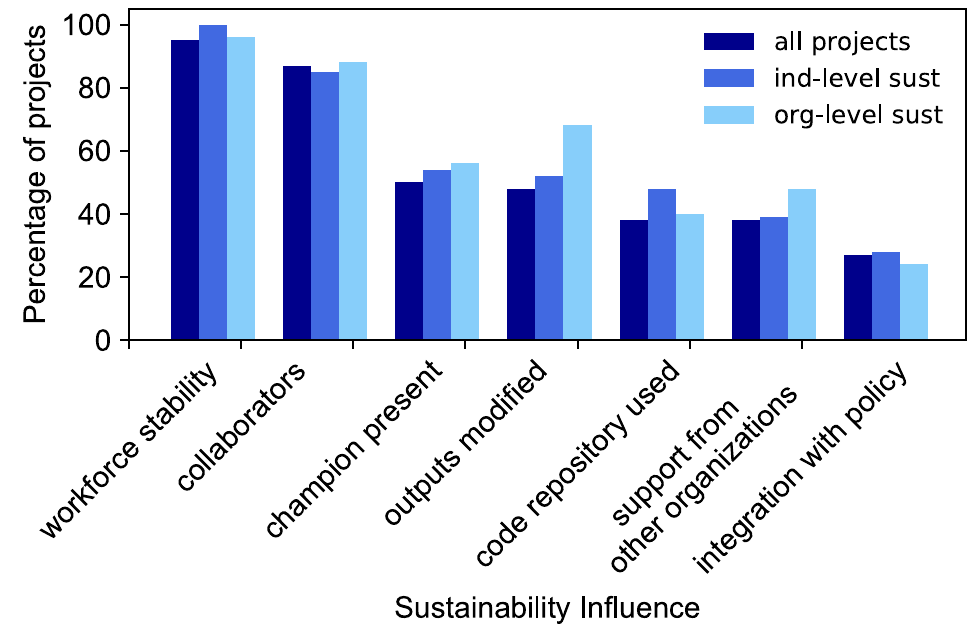
Fig 6. Percentage of projects from each of the three groups with a particular sustainability influence. Dark blue: the group of all projects, medium blue: projects that have achieved individual-level sustainability, light blue: projects that have achieved organization-level